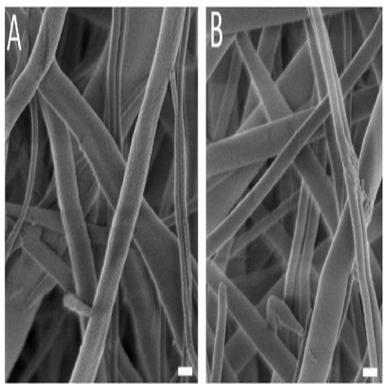
SEM image of A) nonmodified nanofibers and B) nanofibers modified with stilbene 4b after base treatment. The scale bar shows 200 nm.